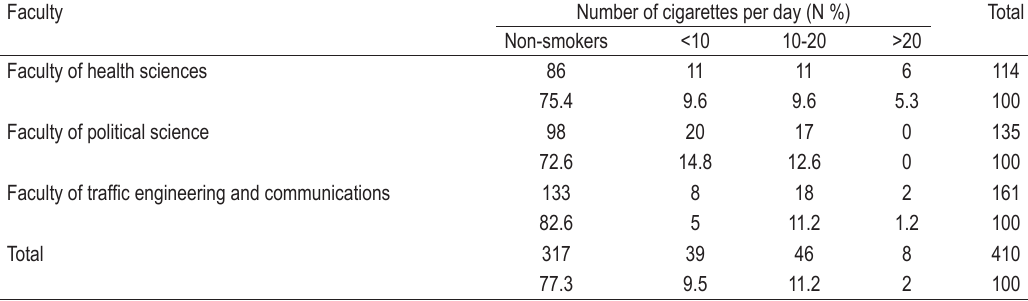
TABLE 3. The number of cigarettes smoked per day among students in three groups